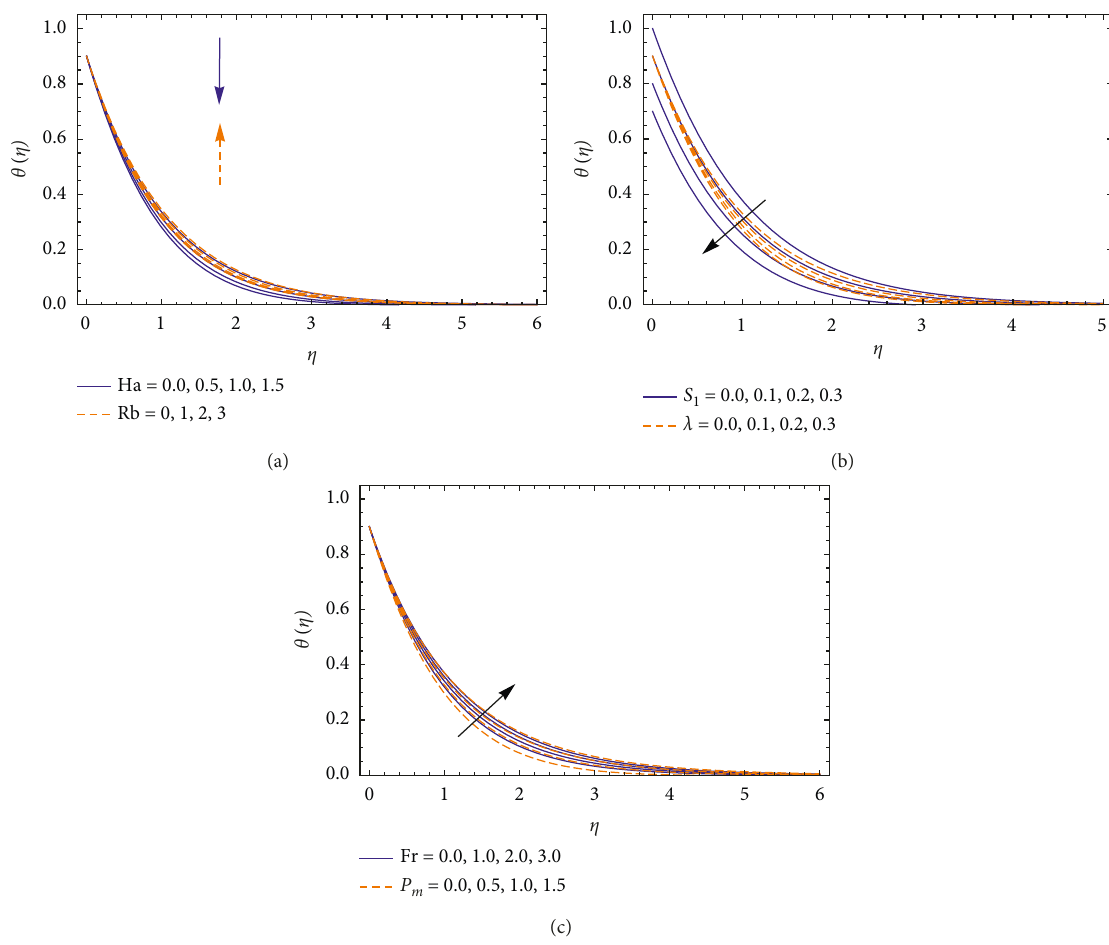
Figure 3: Temperature profile for different values of Ha, Rb, S